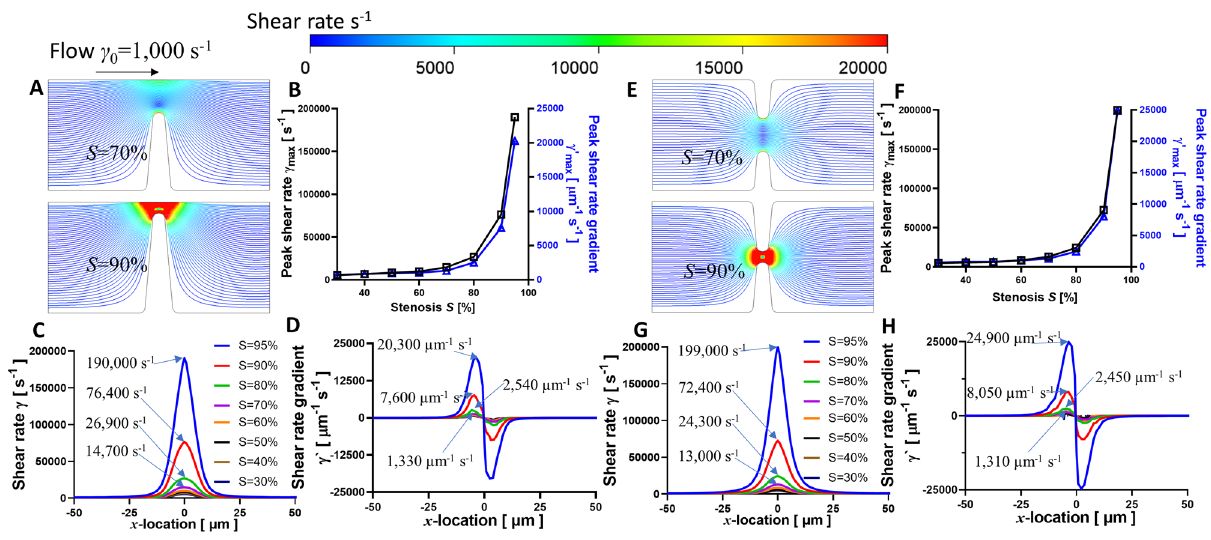
Figure 3. CFD simulated shear rates and shear rate gradients in eccentric ( A – D ) and concentric ( E – H ) stenoses geometry under various stenosis level. ( A and E ) The streamlines of blood flow in the eccentric and concentric stenosis microfluidic channels for S = 70% ( top ) and 90% ( bottom ) respectively. The representative streamline of a platelet trajectory was colored by shear rate values. ( B and F ) Peak shear rate γ max exponentially correlates with the input stenosis level S for both eccentric and concentric stenoses respectively. Note that the concentric γ max is higher than that of eccentric stenosis channel. The shear rate γ ( C and G ) and shear rate gradient γ ′ ( D and H ) distribution is plotted along a sample streamline 1 µm above the stenosis apex spanning the shear acceleration ( x = −100 to 0 µm) and deceleration ( x = 0–100 µm) zones. Note that γ max and γ ’ max occur at the same location as in Fig.